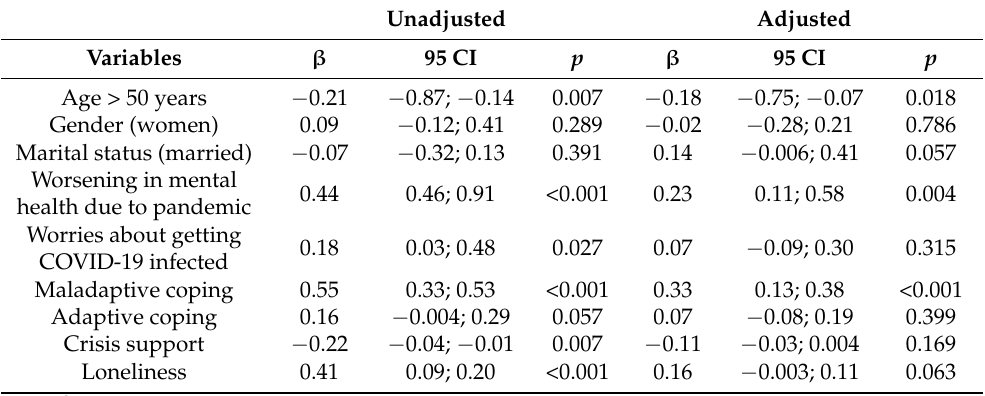
Table 2. Factors associated with anxiety symptoms according to HSCL-25 ( n = 161).